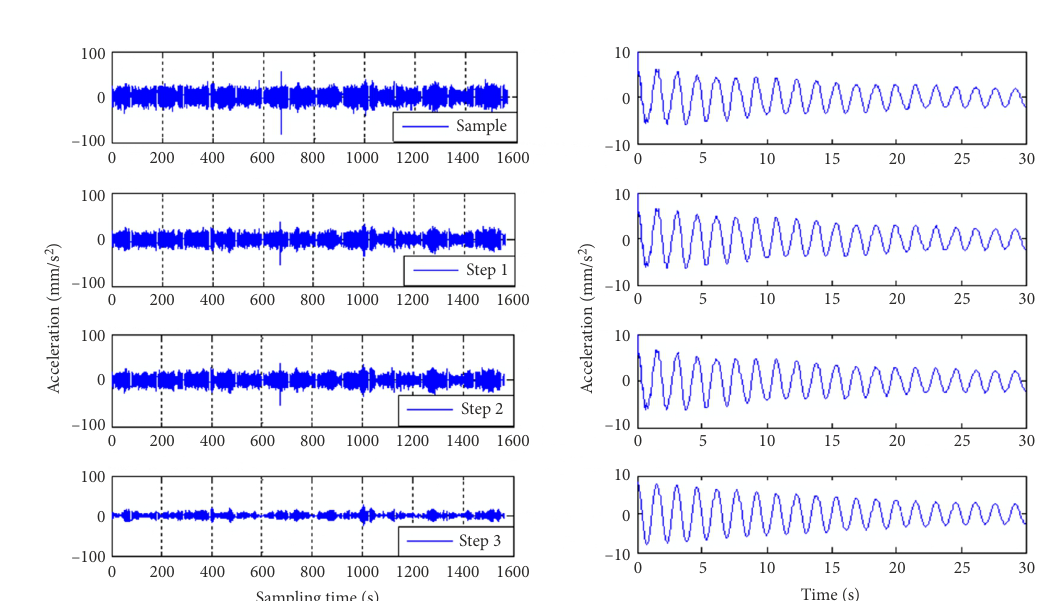
Figure 7. Comparisons of random decrement signatures after being processed by RDT: Step 1 – the data after being processed by five-spot triple method; Step 2 – the data after being removed from multinomial trend items on the basis of Step 1; Step 3 – the data after being processed by band pass filtering on the basis of Step